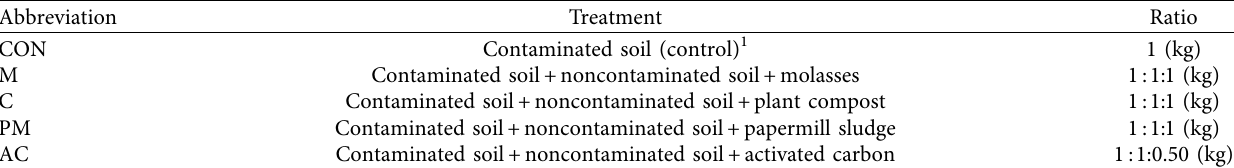
Table 1: Treatments applied to oil-contaminated soil, microcosm